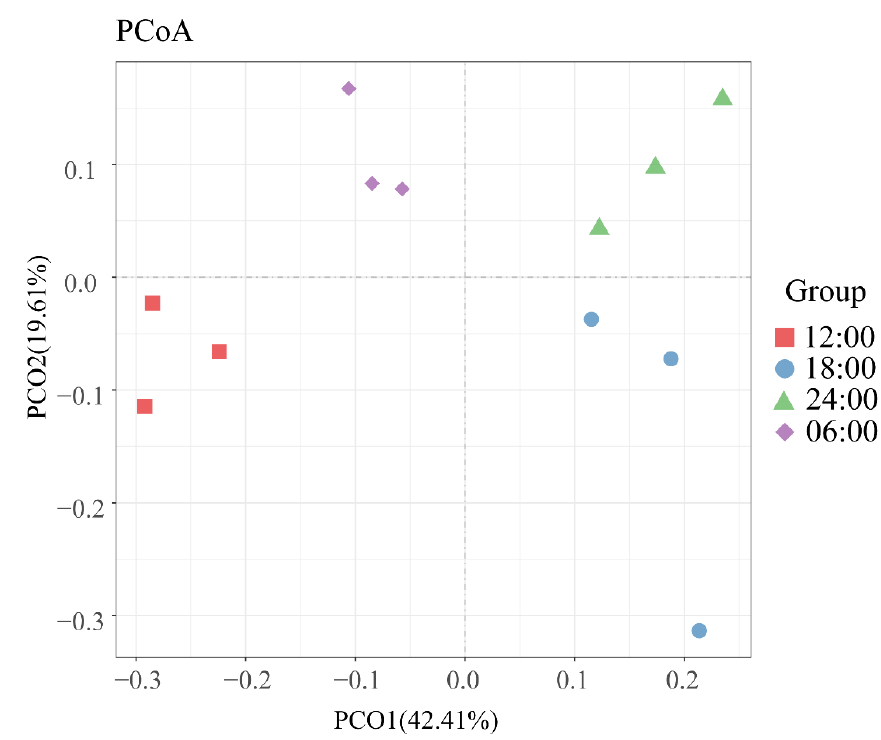
Figure 5. Principal coordinate analysis (PCoA) of the gut bacterial community.